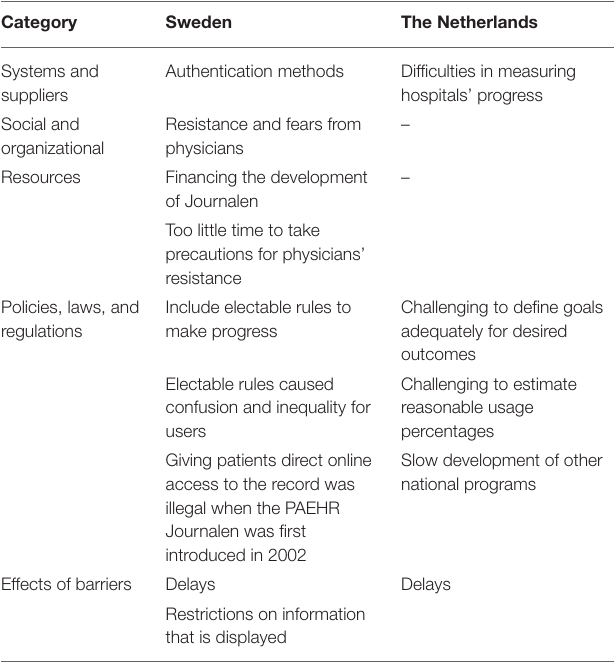
TABLE 3 | Barriers on the national